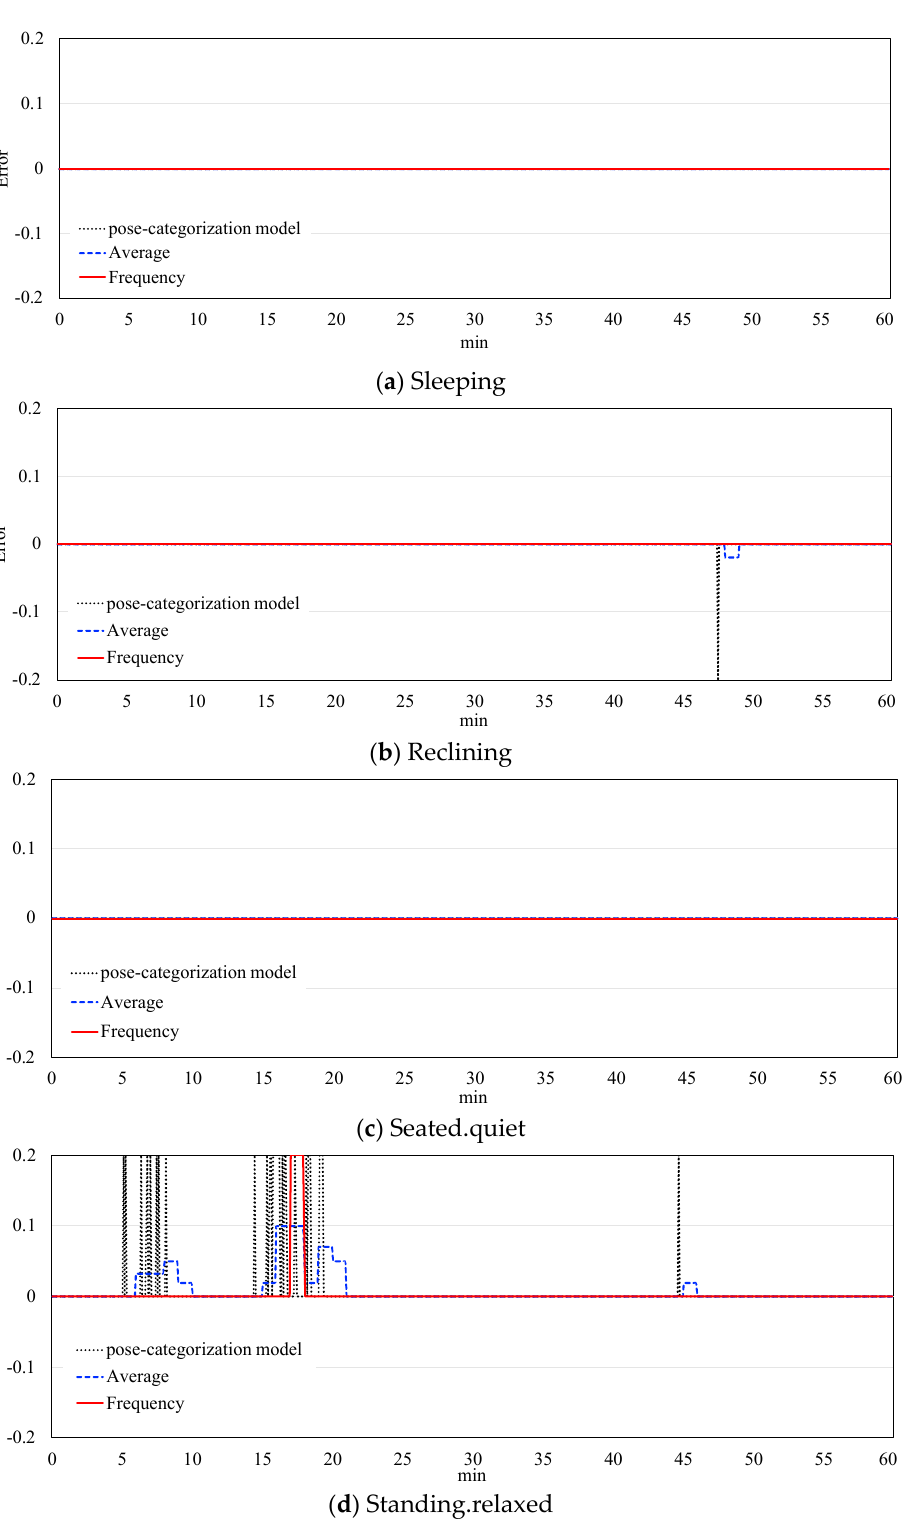
Figure 9. Errors of the two methods and the model in the case of the home activities